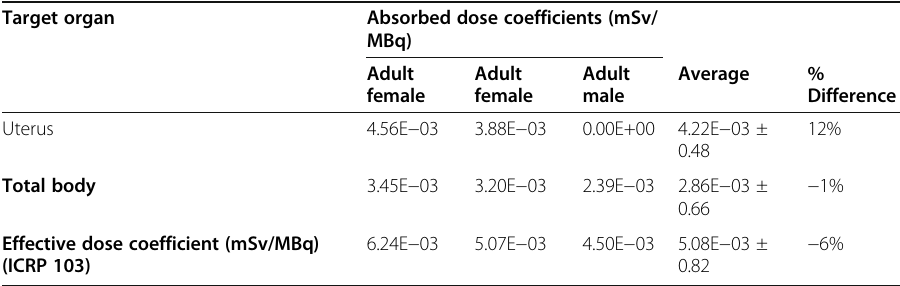
Table 4 Absorbed dose coefficients for [ 11 C]-UCB-J determined from three healthy subjects using OLINDA/EXM 2.1, compared to OLINDA/EXM 1.1